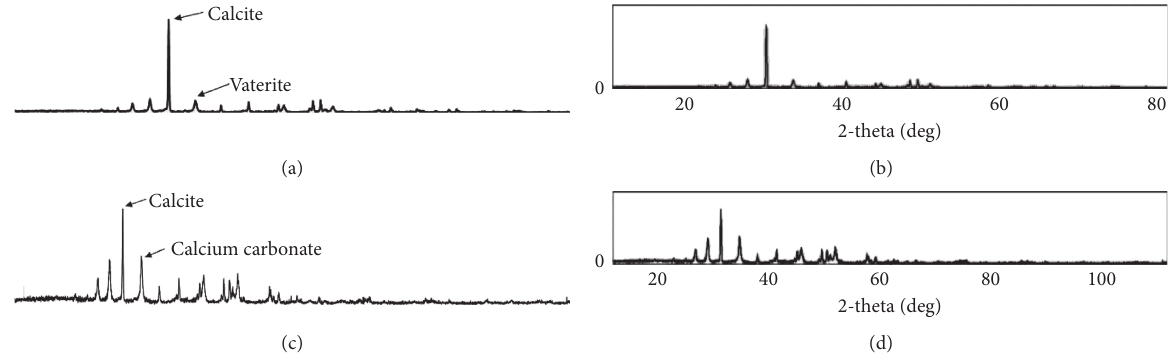
Figure 7: XRD spectra for (a) untreated case and (b) standard peaks of calcite and Vaterite and for (c) UV-treated case and (d) standard peaks of calcite and calcium